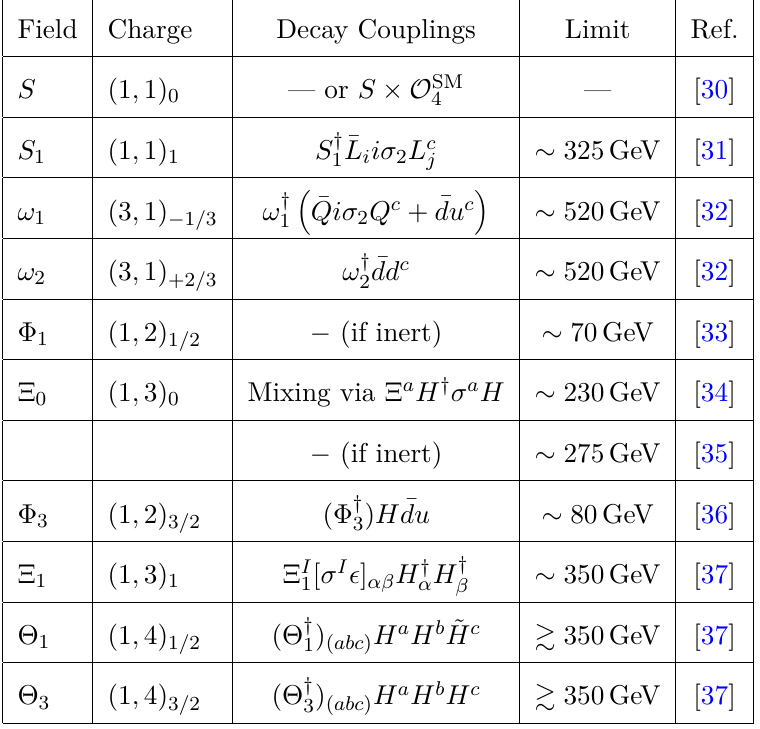
Table 11 . Assumed decay couplings and direct search limits on scalar Loryons organized by SM